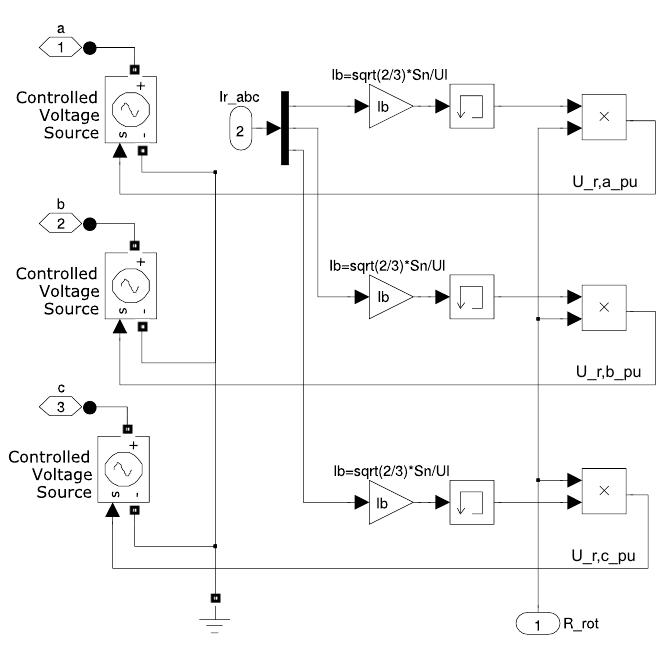
Figure 15. Rotor voltage set for the wound rotor asynchronous generator.